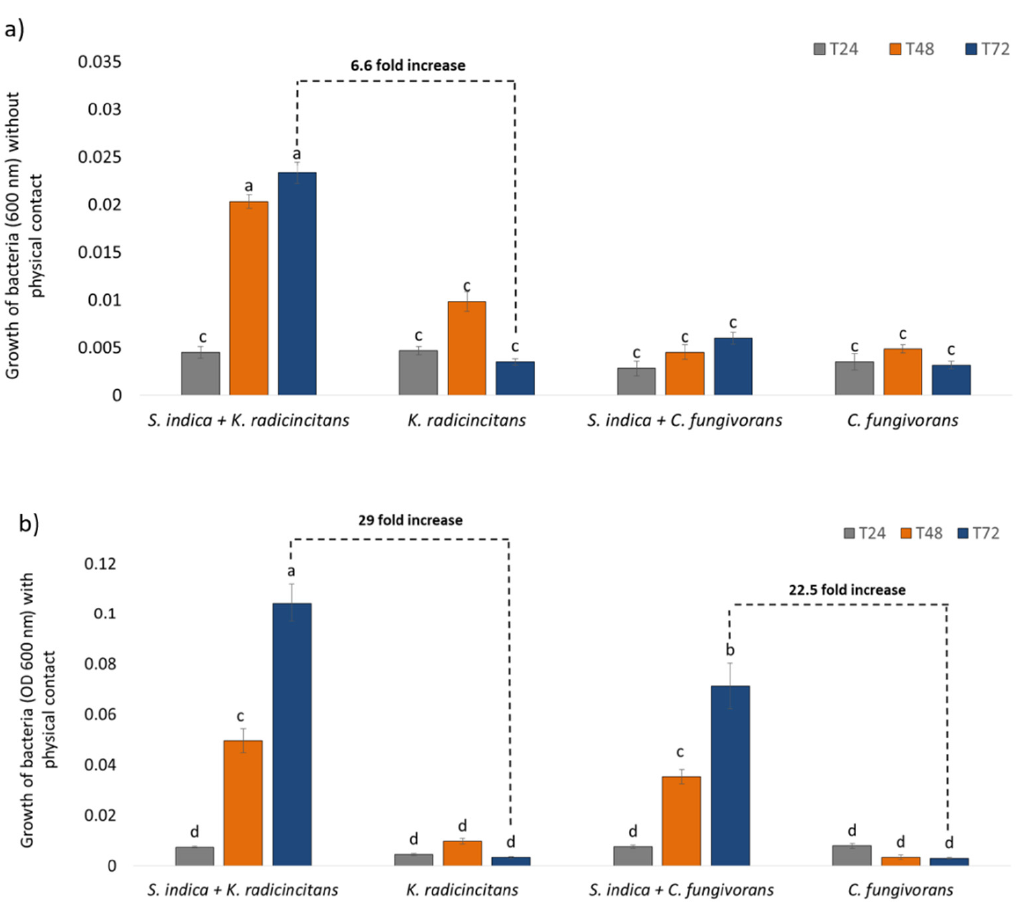
Figure 4. ( a ) Growth of C. fungivorans and K. radicincitans when co-cultivated without physical contact with S. indica. ( b ) Growth of C. fungivorans and K. radicincitans when co-cultivated with physical contact with S. indica . Different letters above bars represent significant differences ( p < 0.05) according to three-way ANOVA with bacteria ( C. fungivorans or K. radicincitans ), fungus (with S. indica or without S. indica ), and time (2 h and 72 h) as factors followed by a Tukey’s additive test. Error bars indicate the standard deviation of means of six different replicates.